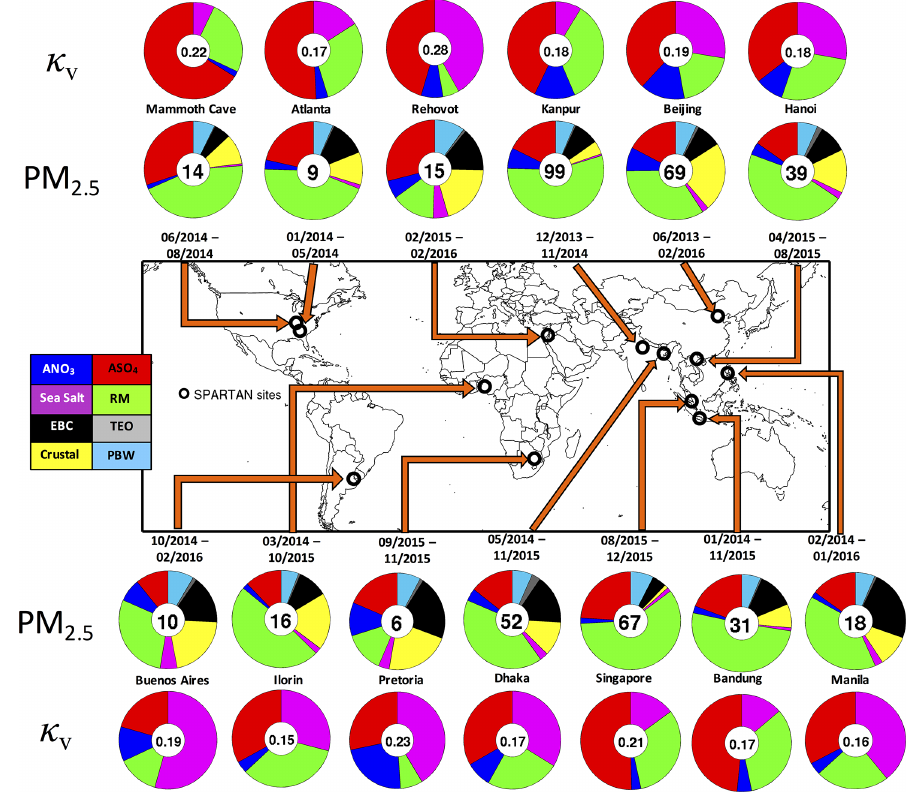
Figure 2. PM 2 . 5 mass (inner circle, µgm − 3 ) and composition mass fraction (filled colours) is shown in interior pie charts. Exterior pie charts contain site-mean κ v surrounded by the relative contribution of PBW water at 35%